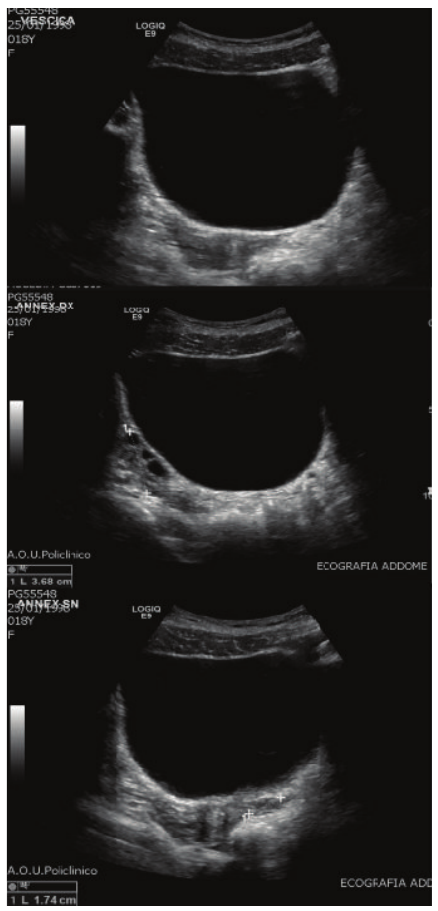
Figure 5: The US examination after 24-month follow-up reveals no recurrence in the left ovary nor metachronous mass in the right